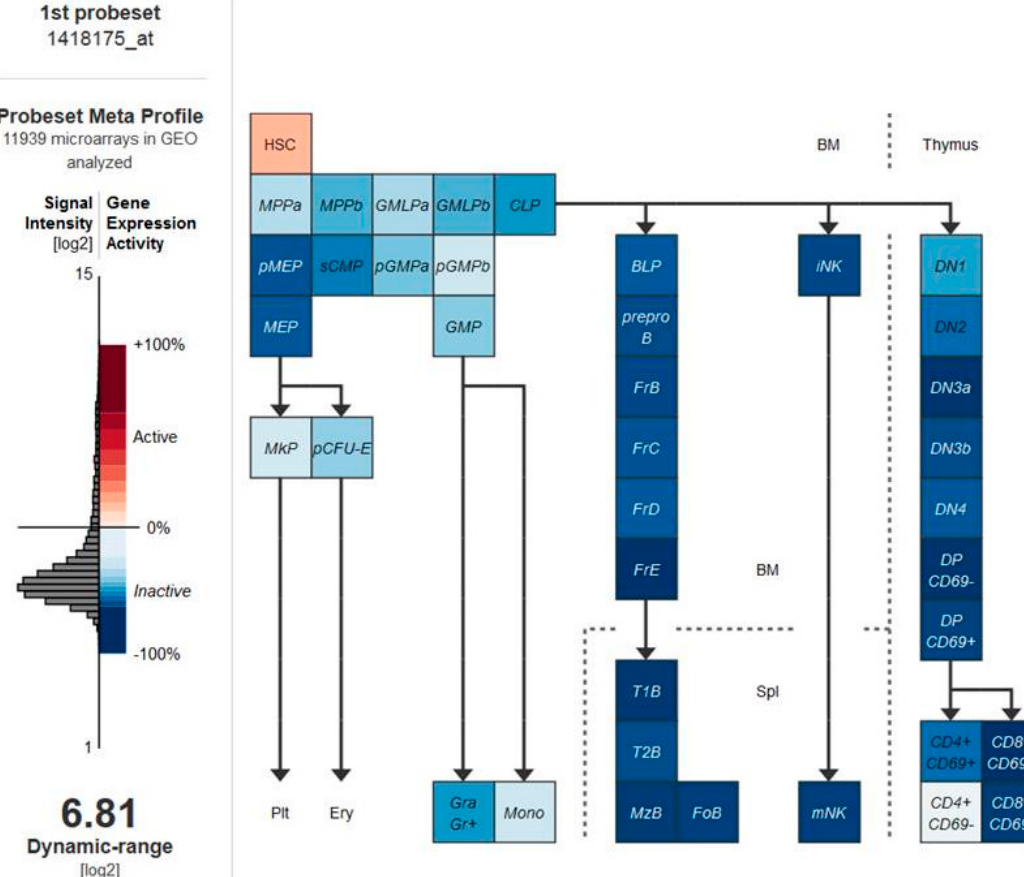
Figure 1. The vitamin D receptor ( VDR ) gene is significantly higher in normal hematopoietic stem cells (HSCs) than in the committed progenitor cells. We analyzed the relative expression of the VDR gene within 39 populations of mouse hematopoietic cells exploiting the Gene Expression Commons platform [48] (increased expression is represented in pink and decreased expression in blue). HSC (Hematopoietic Stem Cells population); MPPa (Multi-potent Progenitor subset A); MPPb (Multi-potent Progenitor subset B); GMLPa (Granulo/Macrophage/Lymphoid Progenitor subset A); GMLPb (Granulo/Macrophage/Lymphoid Progenitor subset B); CLP (Common Lymphoid Progenitor); pMEP (pre Megakaryocyte/Erythrocyte Progenitor); sCMP (Strict Common Myeloid Progenitor); pGMPa (preGranulocyte/Macrophage Progenitor subset A); pGMPb (preGranulocyte/Macrophage Progenitor subset B); MEP (Megakaryocyte/Erythrocyte Progenitor); GMP (Granulocyte/Macrophage Progenitor); MkP (Megakaryocyte Progenitor); pCFU-E (preCFU-E); Plt (Platelets); Ery (Erythrocyte); Gra (Granulocyte); Mono (Monocyte); BLP (Earliest B-lymphoid Progenitor); preproB (preproB cells); FrB (Fraction B B-cell); FrC (Fraction C B-cell); FrD (Fraction D B-cell); FrE (Fraction E B-cell); T1B (T1 B-cell); T2B (T2 B-cell); MzB (Marginal Zone B-cell); FoB (Folicular B-cell); iNK (intermediate Natural Killer Cell); mNK (mature Natural Killer Cell); DN (Double Negative T-cell); DP (Double Positive T-cell).